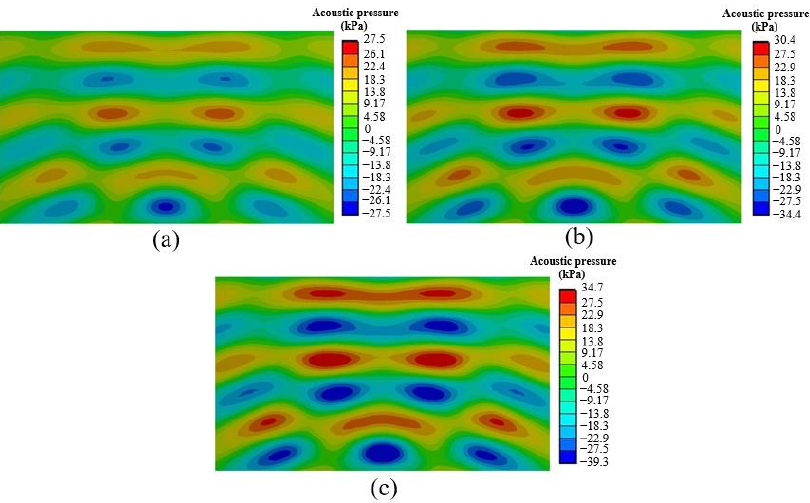
Figure 8. Acoustic pressure distribution from the TDA of 28 kHz UCT for transducer power of ( a ) 300, ( b ) 350, and ( c ) 400 W.